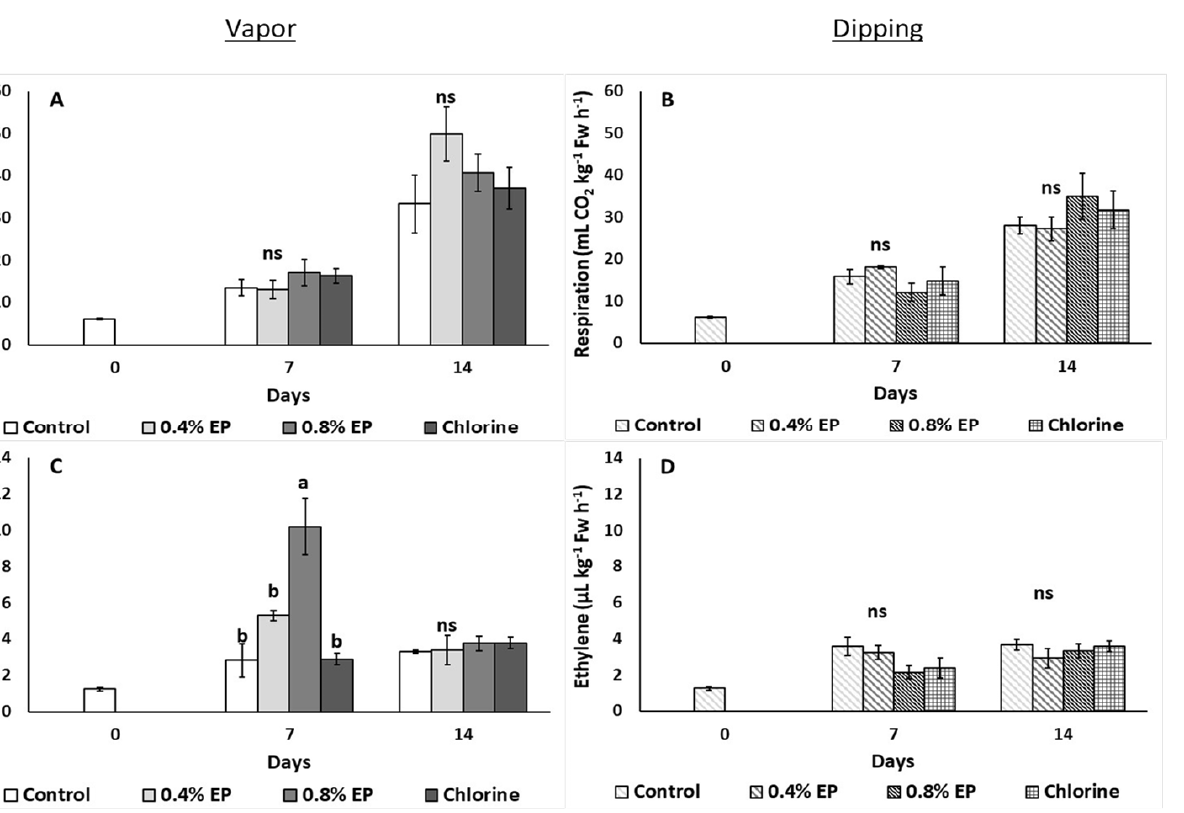
Figure 4. Effects of vapor ( A , C , E ) or dipping ( B , D , F ) application with eco-product (EP) at different concentration (0–0.4% and 0.8%), chlorine (0.02%) or control (application with water) on marketa- bility (scale 1–10), aroma (scale 1–10) and appearance (scale 1–10) of cucumber fruits stored at 11 °C and RH ~90% up to 14 days. Means ± SE followed by different Latin letters are significantly different according to Duncan’s MRT ( p = 0.05). ns: not significant.